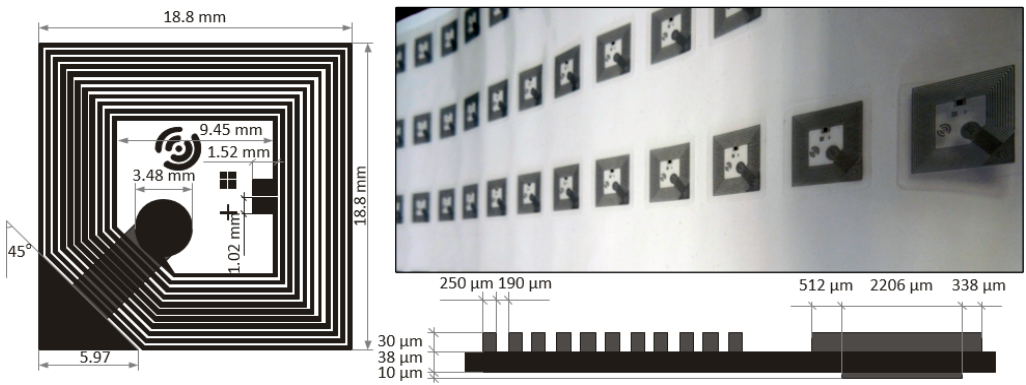
Figure 18. Test antenna of the HF band—parameter designation for the model of commercial antenna.